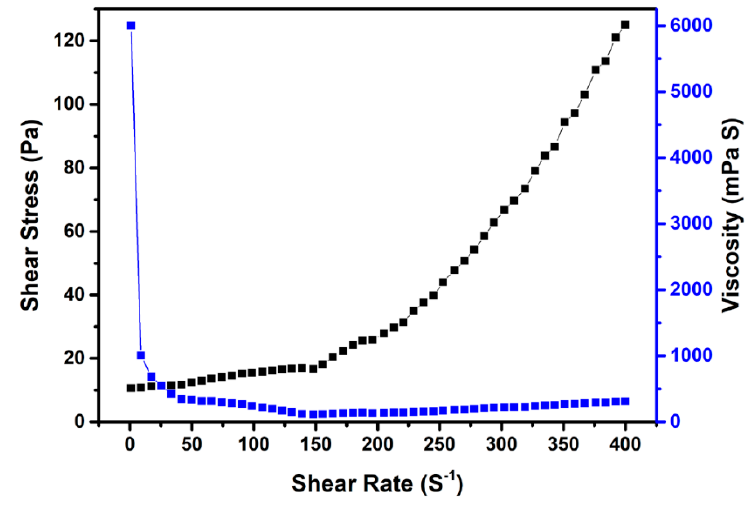
Figure 16. Rheological behavior of the cement paste.